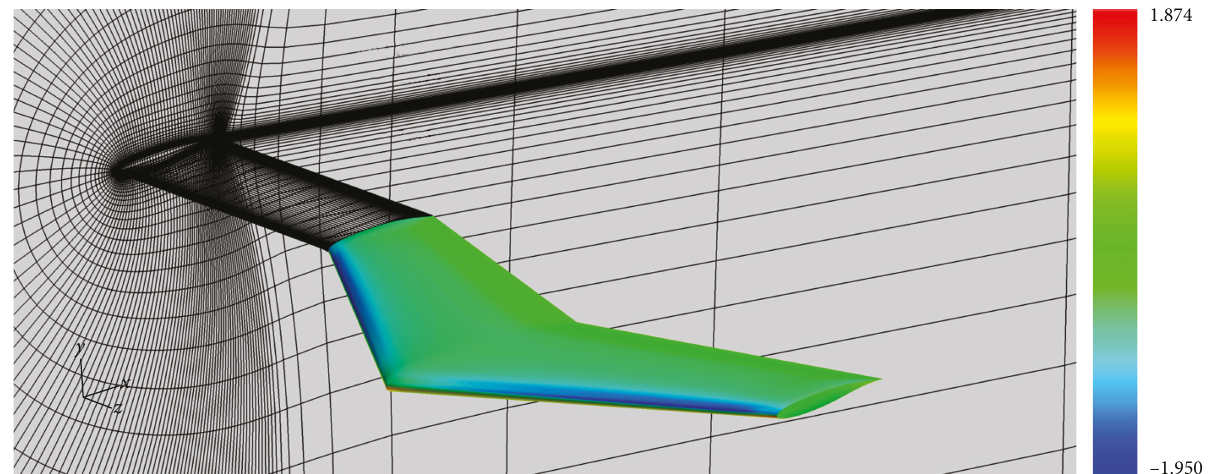
Figure 8: The plain 3D wing constructed from the BGK airfoil.